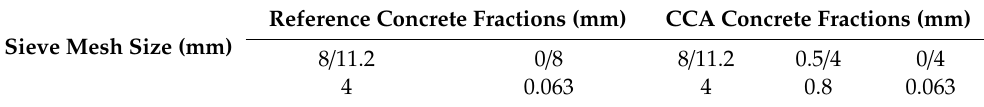
Table 1. Sieves for washing di ff erent aggregate fractions during mechanical pre-processing Reference Concrete Fractions (mm) Sieve Mesh Size (mm)